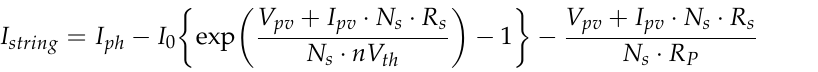
Figure 4. One-diode equivalent circuit model of a PV